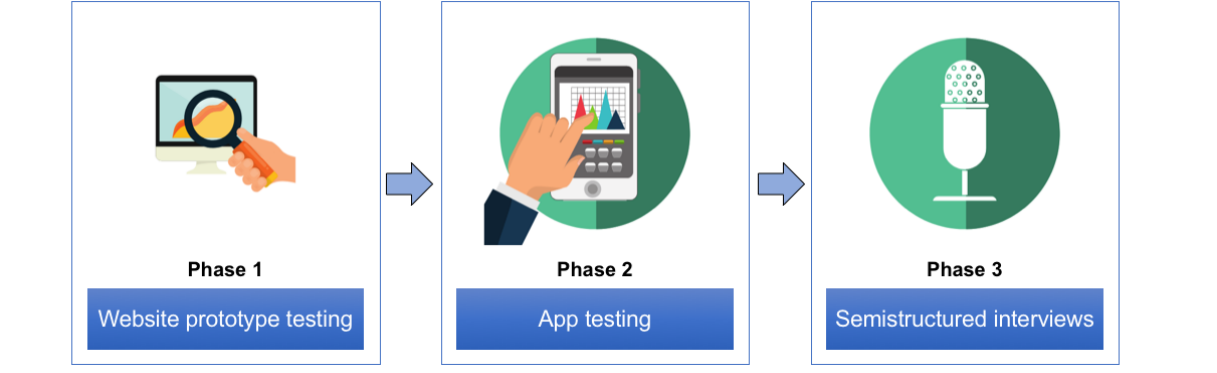
Figure 1. A 3-phased approach to the user testing was adopted, with all participants undertaking user testing of website prototypes (phase 1), pain app user testing (phase 2), and semistructured interviews on their experiences of using these digital technologies (phase